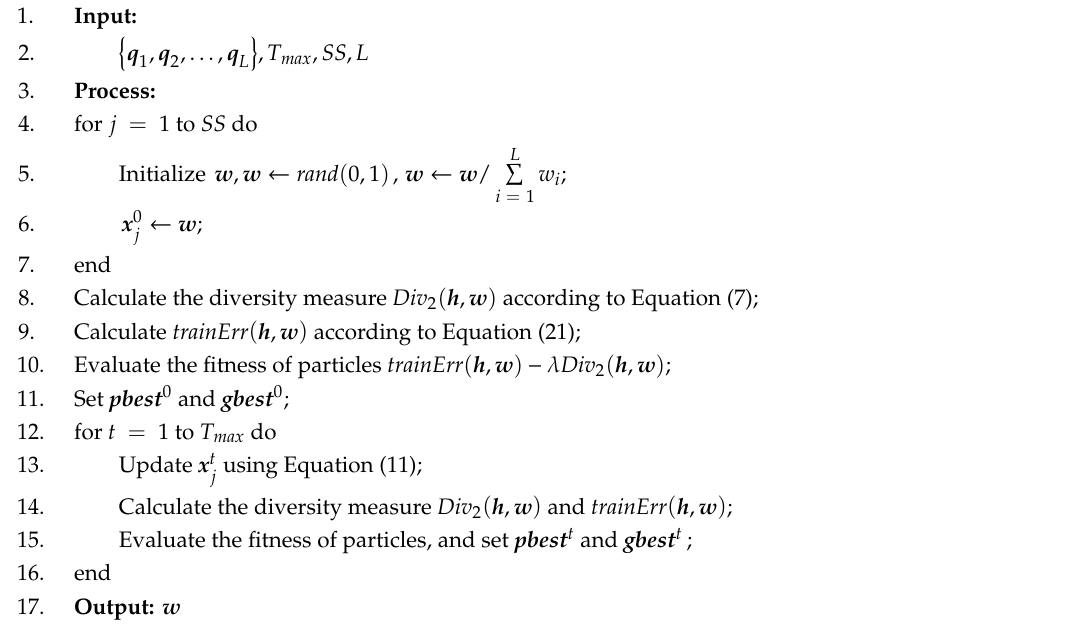
Algorithm 2. Using PSO to optimize the weight parameters of the classifier w